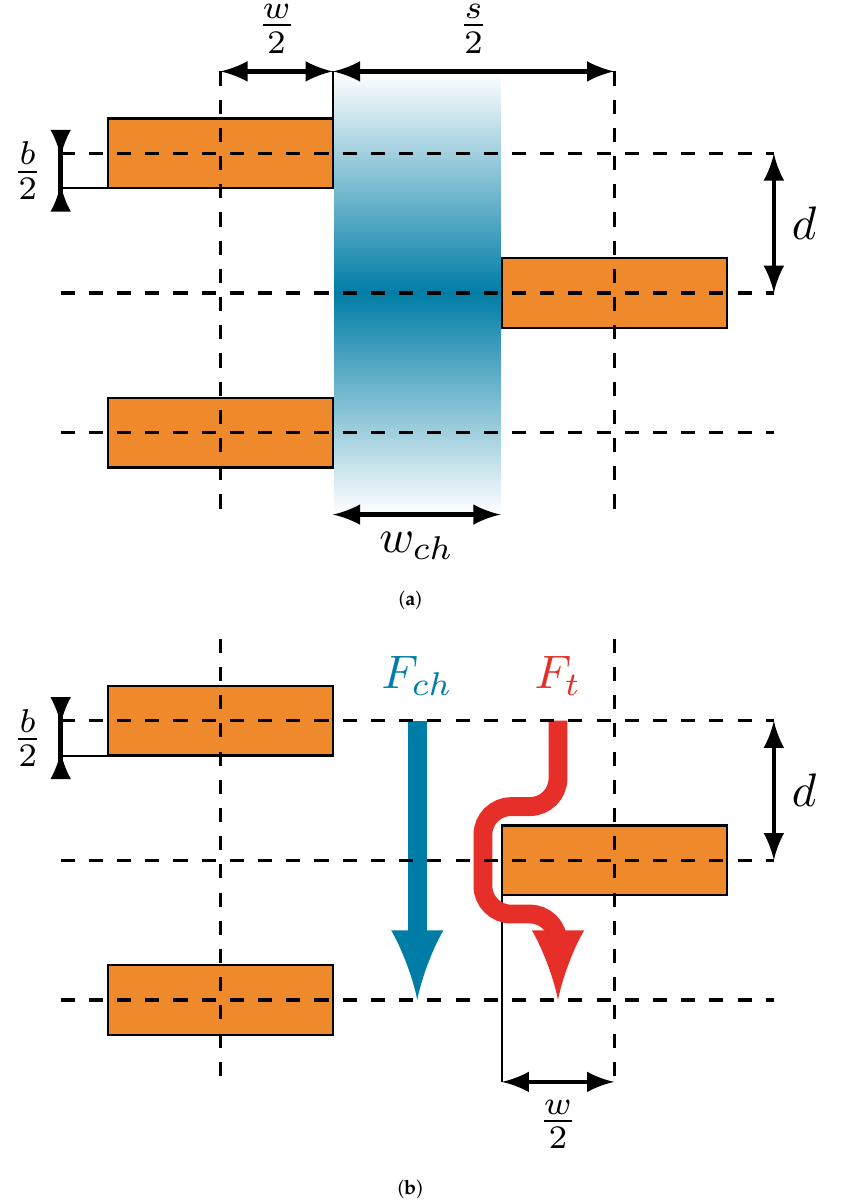
Figure 3. Model sketches. ( a ) Sketch of unit cells (enclosed with dashed lines) with a channel (blue) through the filler rows in which diffusion takes place unhindered. ( b ) Sketch of two superimposed flows in a unit cell: the unhindered flow through the channel F ch , and the tortuous flow around fillers F t